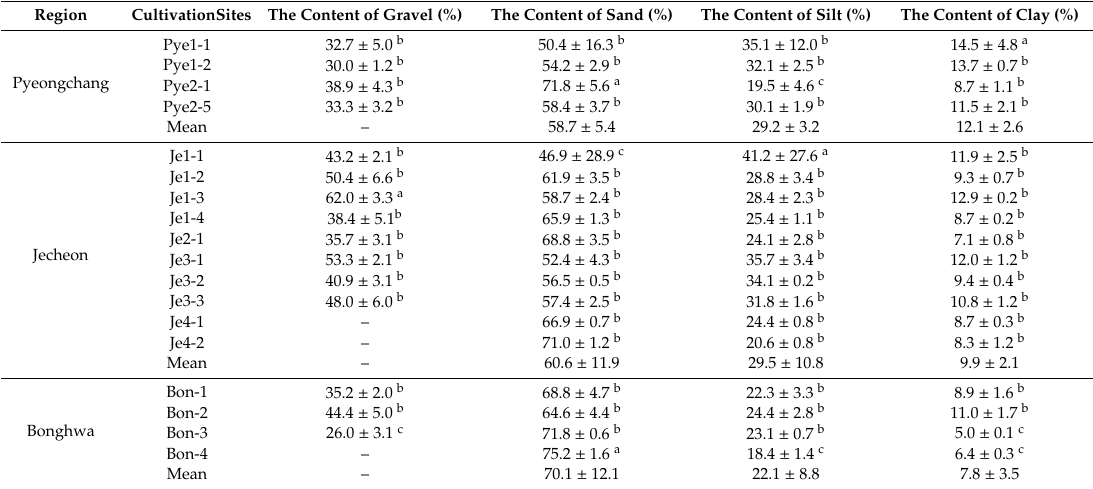
Table 1. Soil textures in Angelica gigas cultivation sites, Korea (mean ± SD).